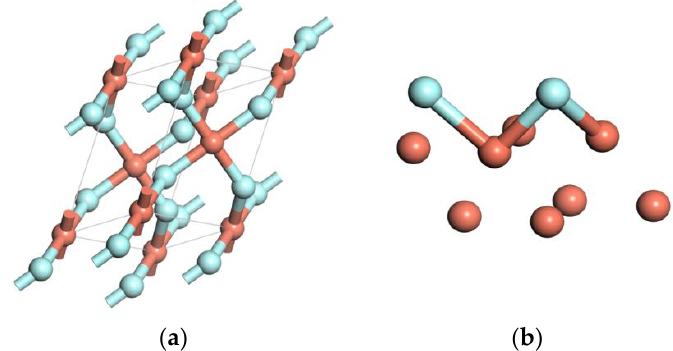
Figure 5. Schematic drawing: ( a ) the CuF 2 unit cell and ( b ) the bonds formed by the F atoms and Cu atoms in Figure 2g.